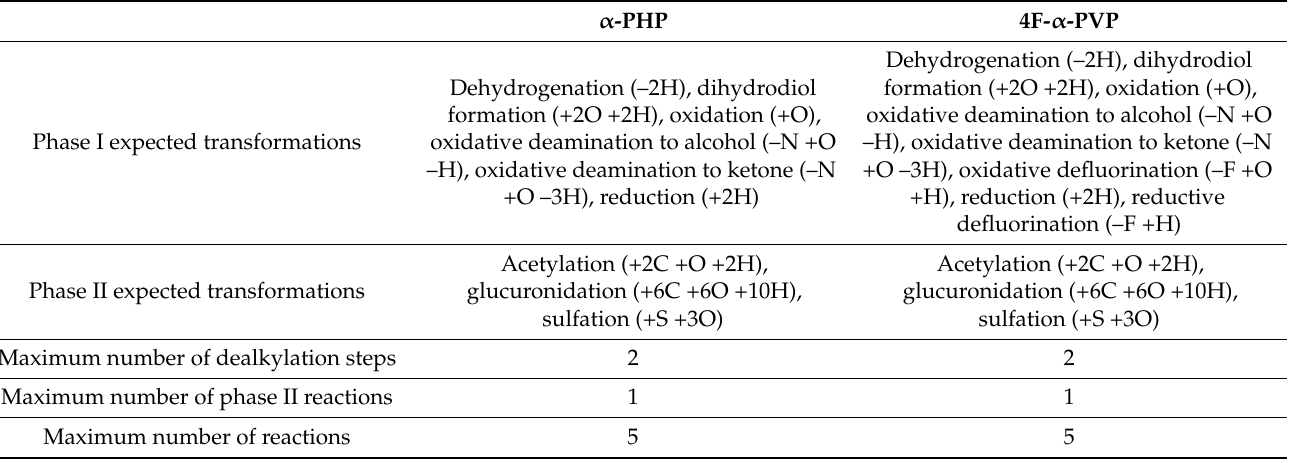
Table 3. Compound Discoverer™ processing settings for identifying α -PHP and 4F- α -PVP